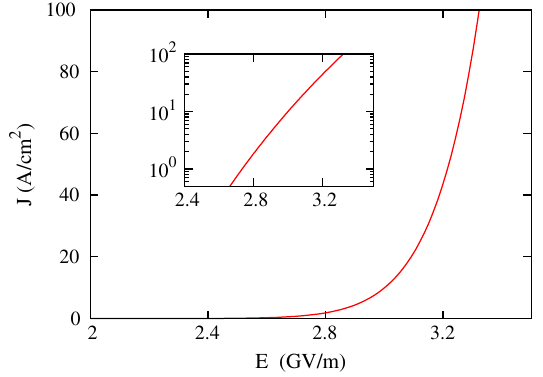
FIG. 3. The rms width of field emission in an rf cycle. For variant emission current densities and work functions, the width only changes a